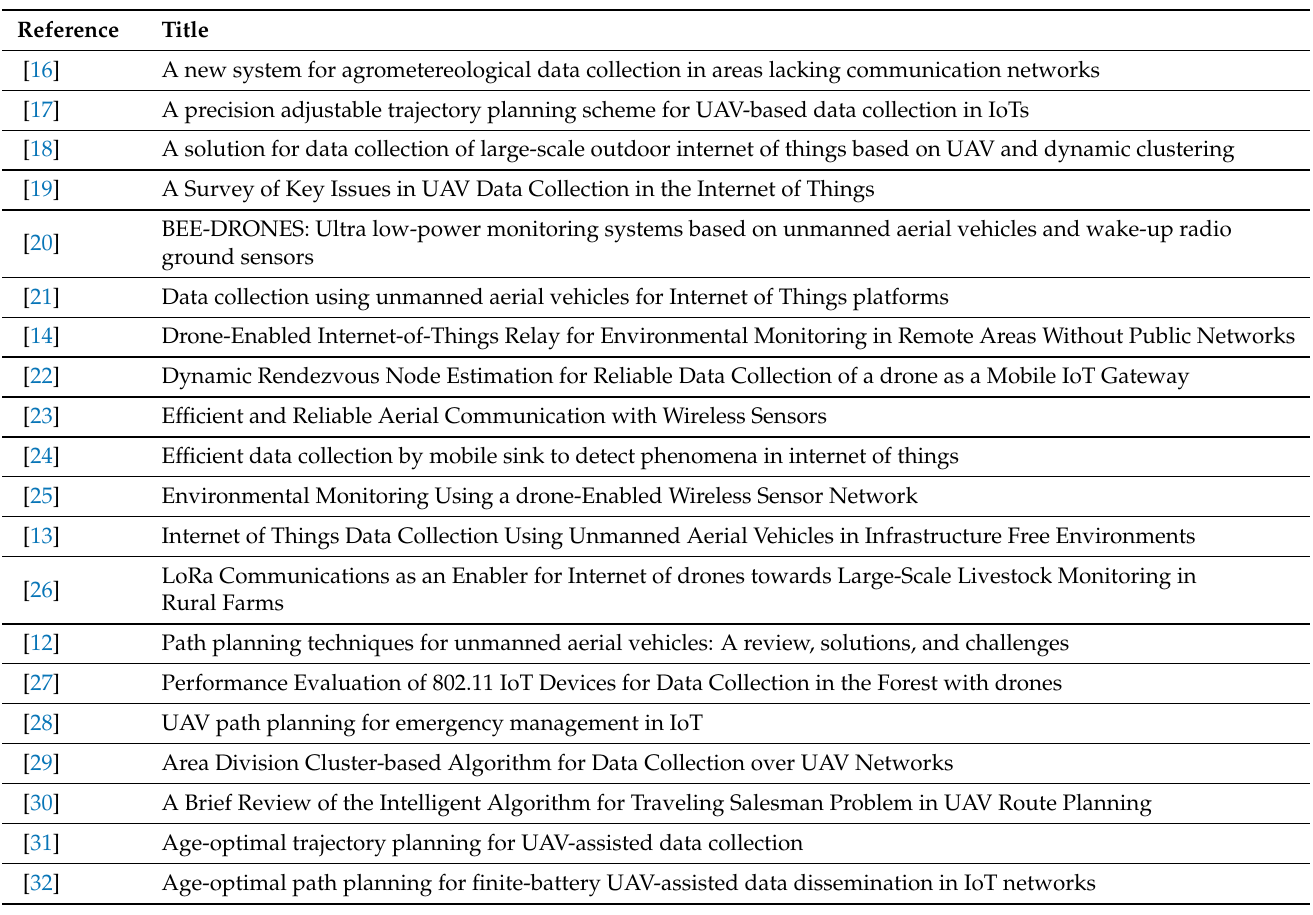
Table 1. Selected papers.